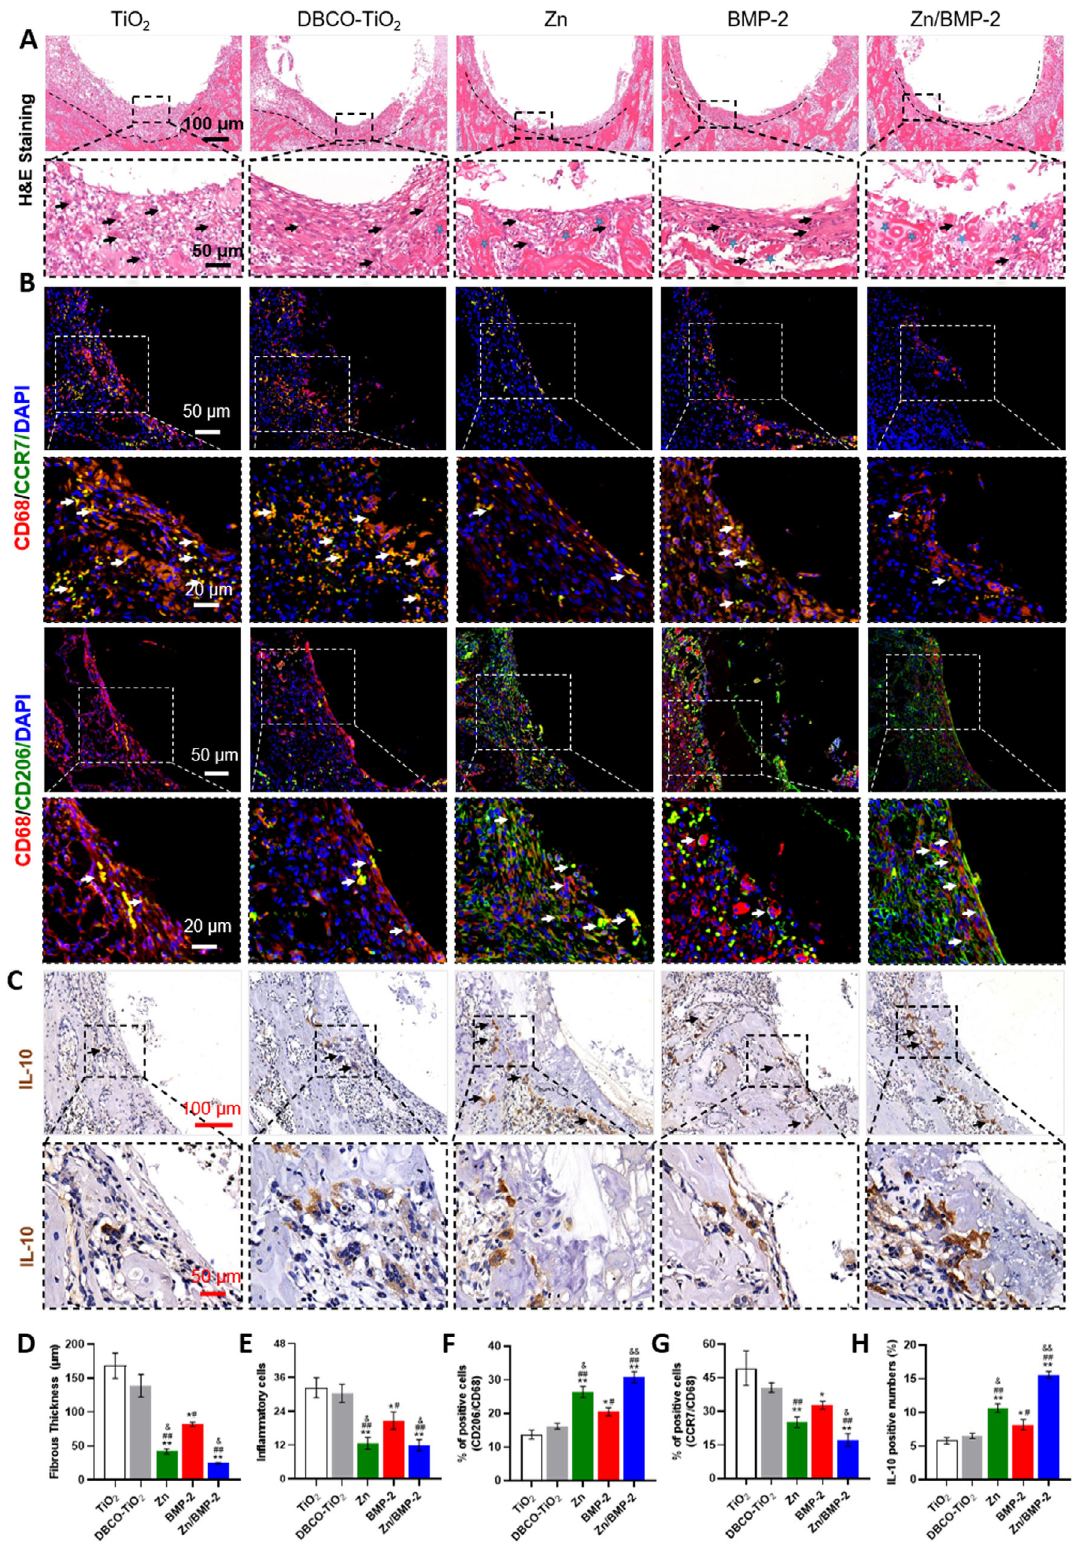
macrophages in the Zn/BMP-2 group (Fig. 6G).